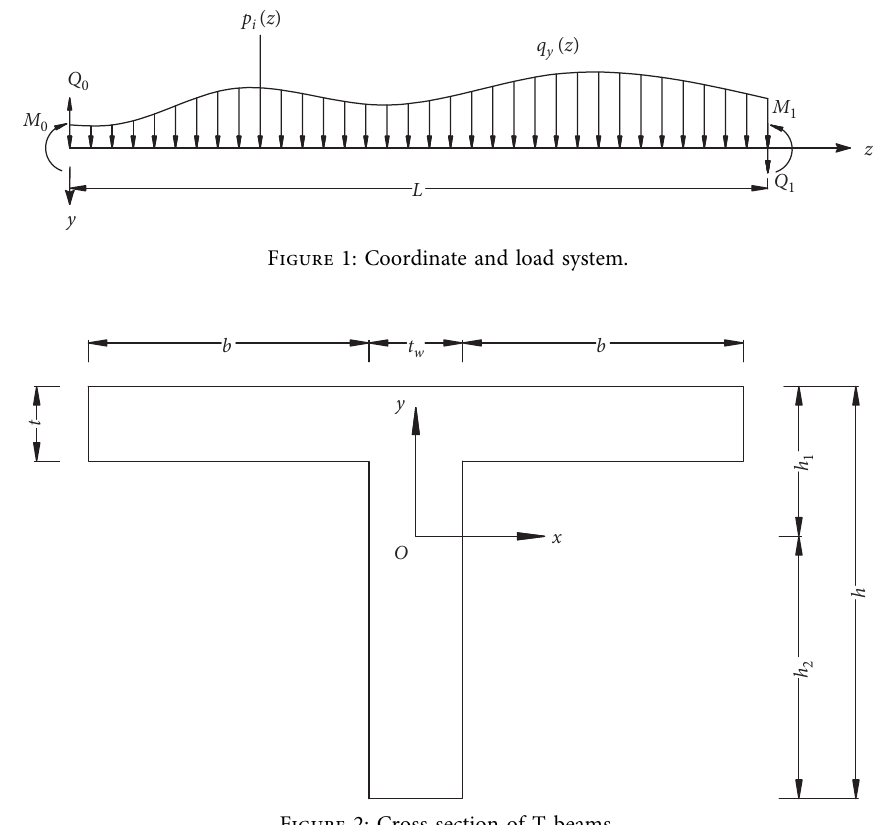
Figure 2: Cross section of